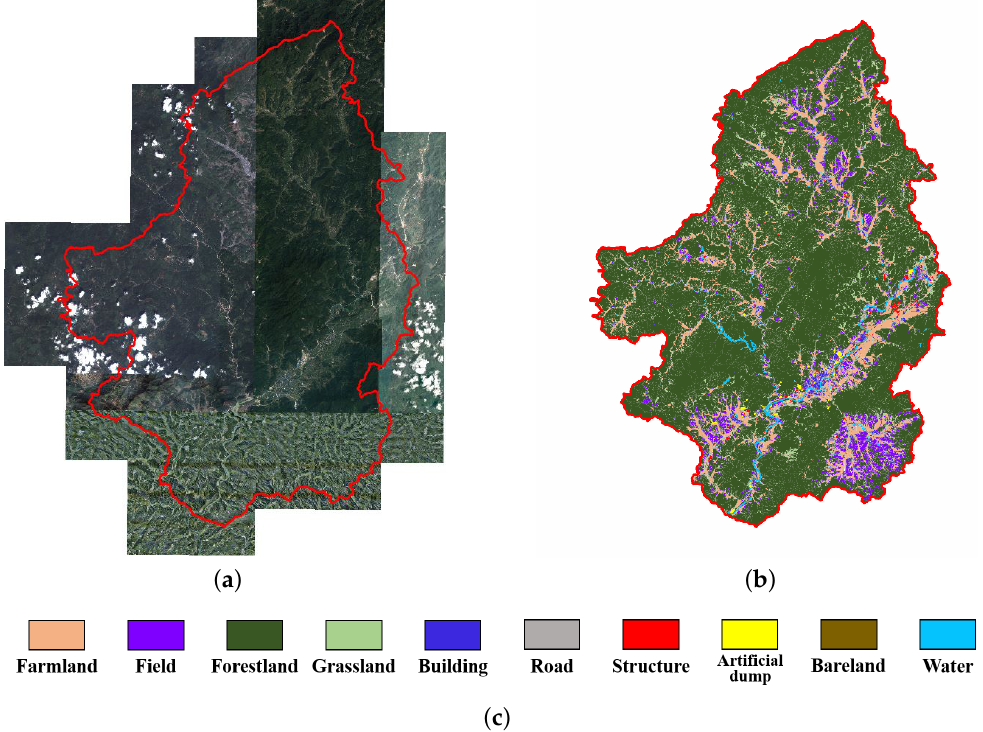
Figure 9. DOMs and the corresponding full-covered label vector data in Songxi County. ( a ) shows DOMs in Songxi dataset; ( b ) shows vector data of the Songxi dataset; ( c ) is the legend of the Songxi